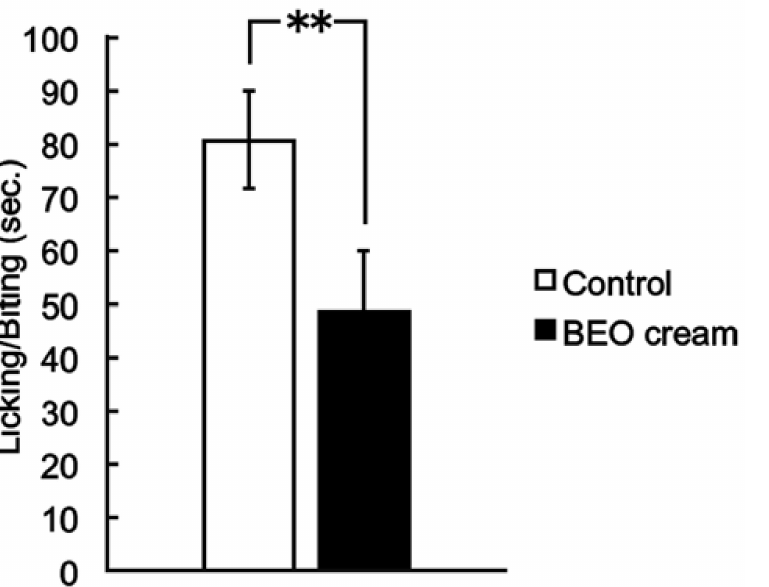
Figure 3. Antinociceptive effect of the topical application of NanoBEO (1 mg/mouse) on the 0.5% formalin test. The nociceptive behavior induced by formalin has been scored as the amount of time spent licking and biting the injected paw. Empty cream (1 mg/mouse) has been used as a control and this has failed to affect the formalin-induced nociceptive response. Values are expressed as mean ± SEM ( n = 8). Values of p < 0.05 have been considered statistically significant. Improvement over control of 59.78%, ** p < 0.01.